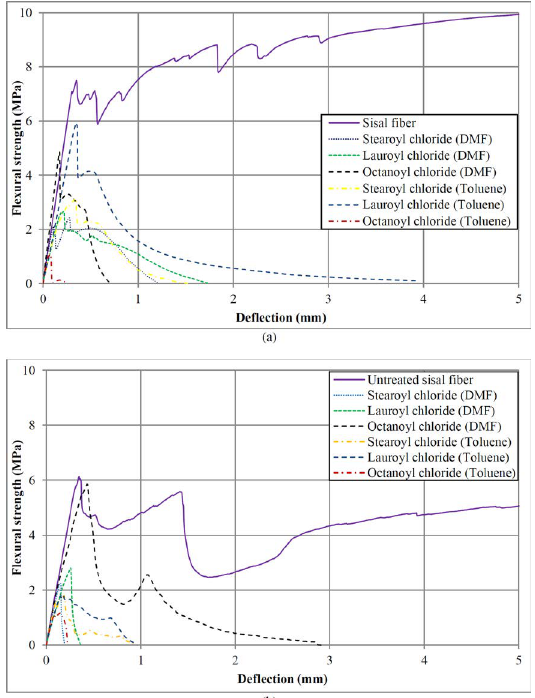
Figure 6. Typical behaviour of composites in the bending test: a) at the age of 28; b) at the age of 90